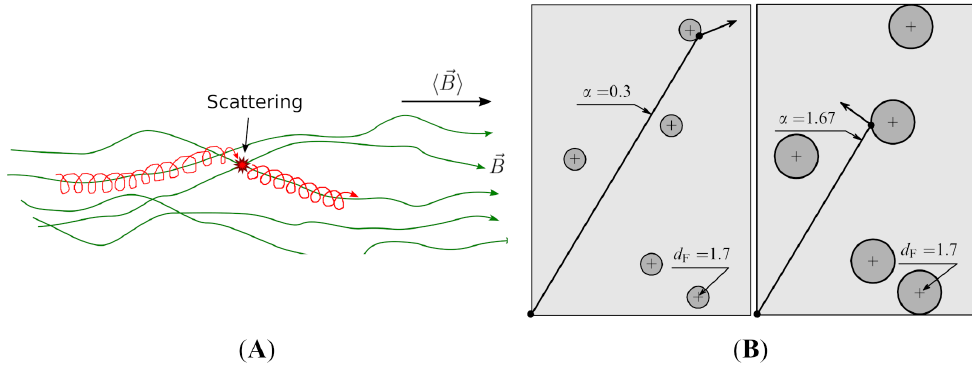
Figure 1. Qualitative sketches of CR particle trajectories in two different models. ( A )—in the wave model; ( B )—in the cloud model ( α are free path distribution indices, d F are clouds diameters).